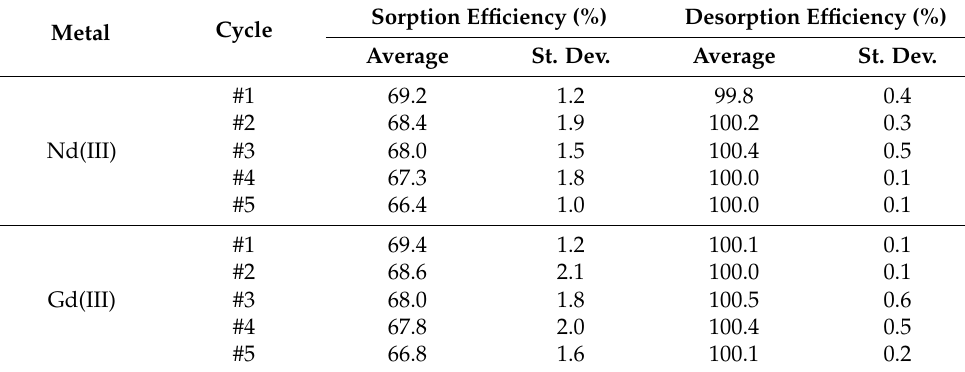
Table 4. Sorption recycling—sorption and desorption efficiencies (average value and standard